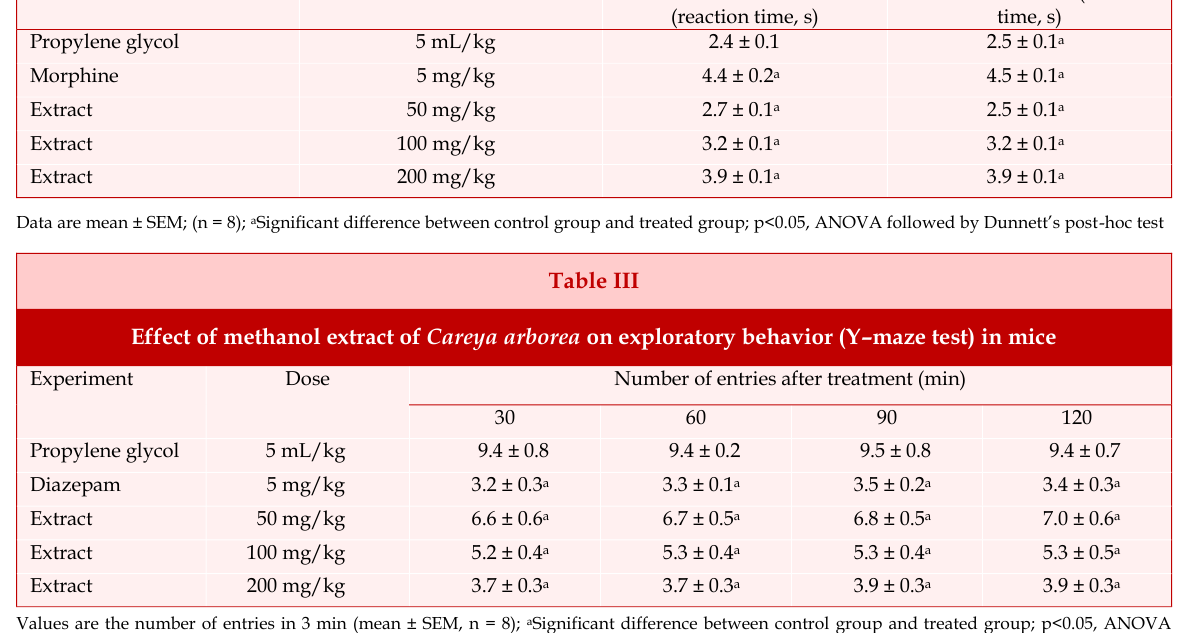
Analgesic effect of methanol extract of Careya arborea on tail flick and tail immersion test in mice and rats